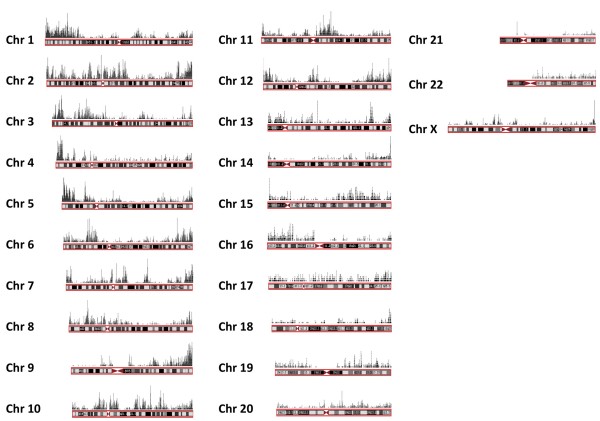
Chromosomal distribution of H4K16ac sites. HEK293 cell genomic DNA was isolated and subjected to ChIP-ChIP analysis using an antibody against H4K16ac and the NimbleGen Human Whole-Genome Tiling Array Set (see Materials and methods). Results are summarized for each chromosome with the bar-height representing the regional log2H4K14ac intensity >2-fold.